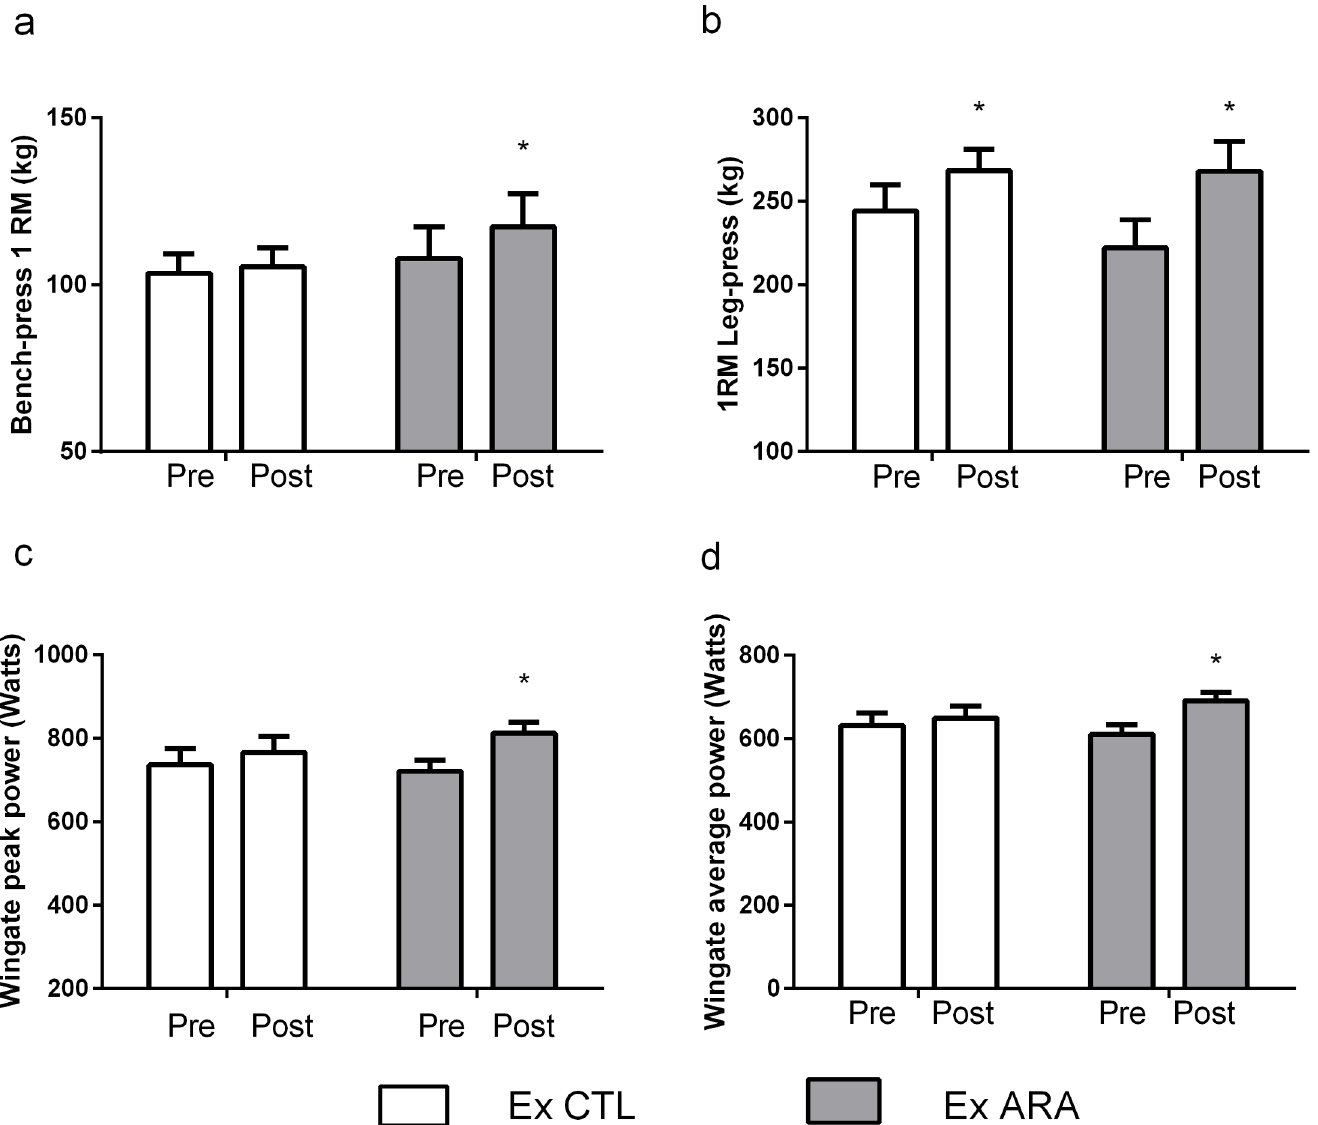
Fig 2. Pre- and post-testing values for bench press 1RM (a), leg press 1RM (b), Wingate peak power (c), and Wingate average power (d for Ex CTL and Ex ARA groups. * — Indicates p < 0.05 for within-group